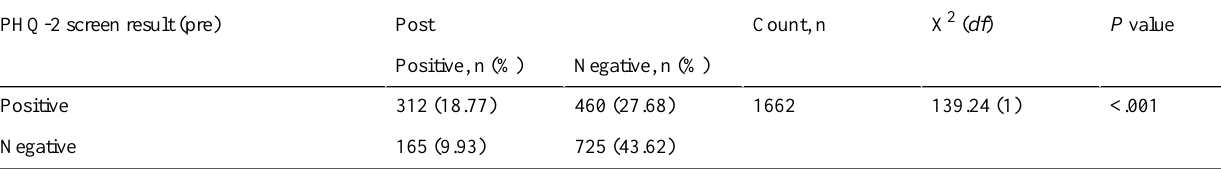
Table 2. Patient Health Questionnaire-2 (PHQ-2) results at intake and follow-up